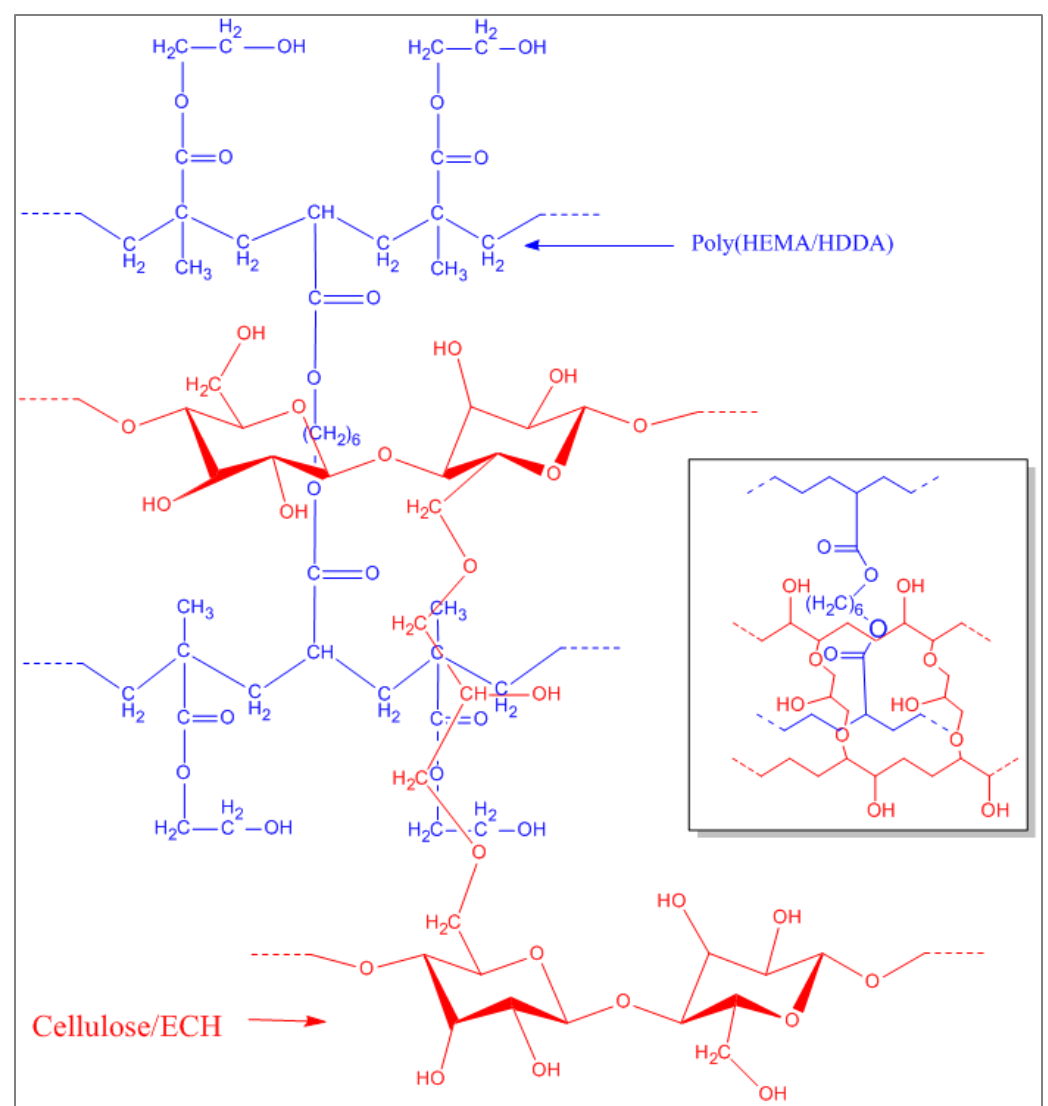
Figure 6. Schematic structure of an IPN based on cellulose and PHEMA, obtained by sequential crosslinking.